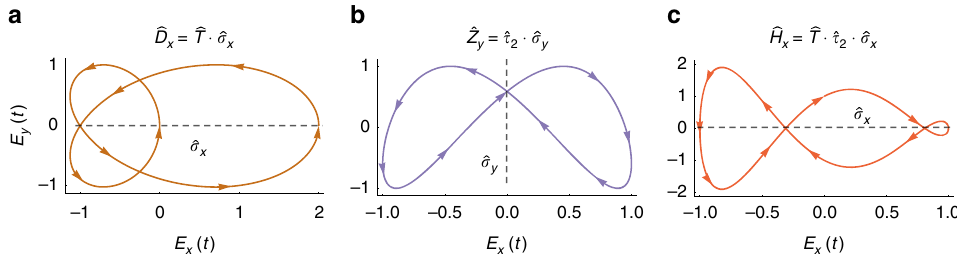
Fig. 1 Order-2 spatiotemporal DSs in (2 + 1)D involving spatial re fl ection with examples for each symmetry. ( a ) ^ D x symmetry for the example fi eld E ( t ) = (cos( ω t ) + cos(2 ω t )) ^ x + sin(2 ω t ) ^ y , ( b ) ^ Z y symmetry for the example fi eld E ( t ) = sin( ω t ) ^ x + sin(2 ω t + π /5) ^ y , and ( c ) ^ H x symmetry for the example fi eld E ( t ) = sin( ω t ) ^ x + cos(3 ω t ) ^ y . The fi elds are represented on Lissajou plots. The spatial parts of the operators is indicated by dashed lines, colored arrows in the plots indicate the direction